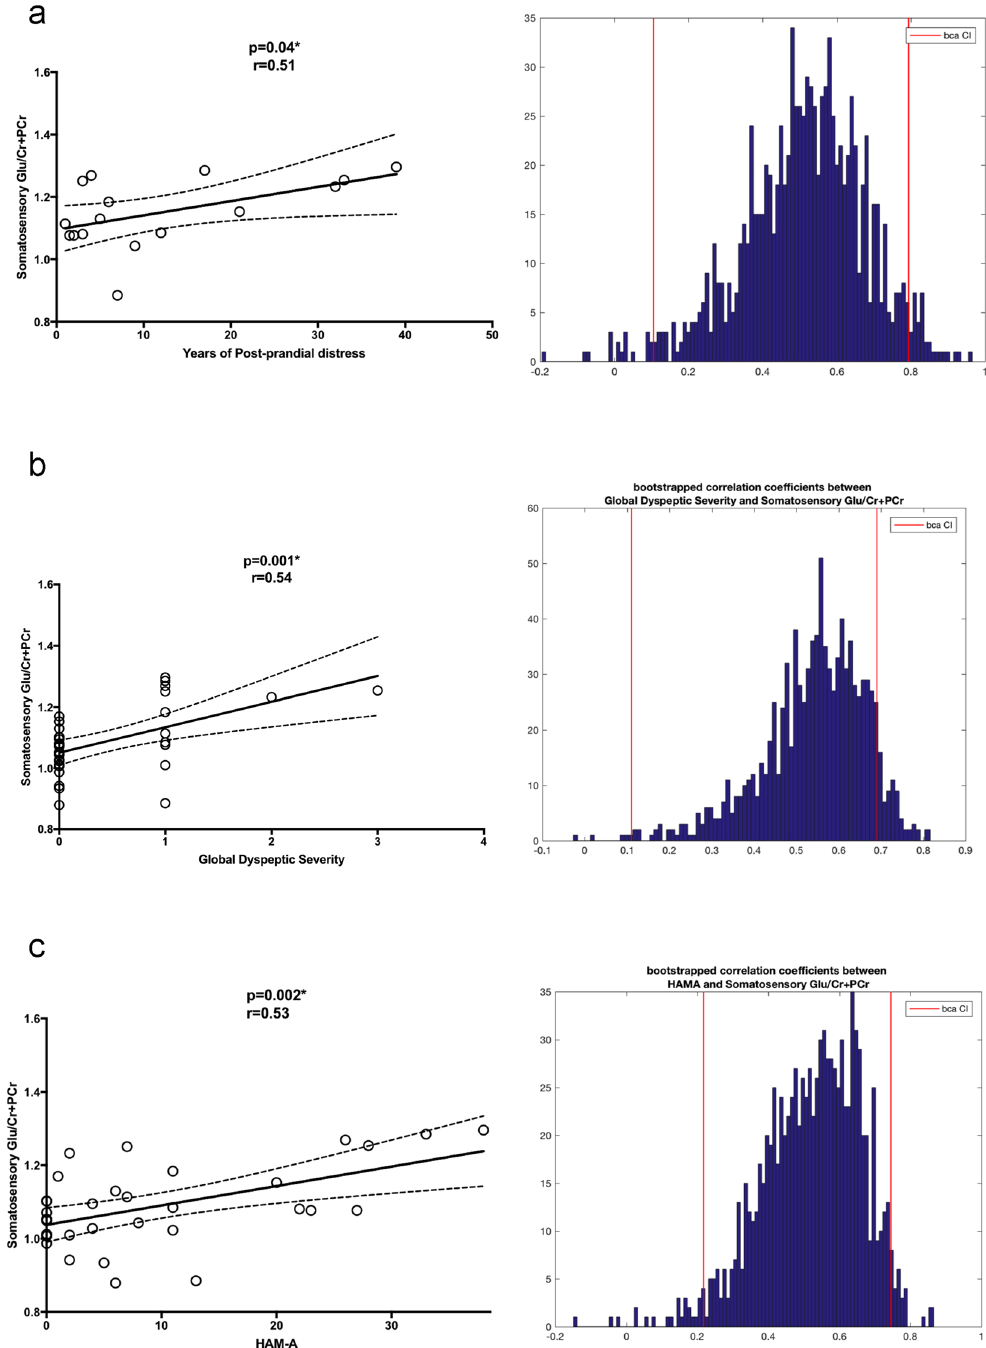
Figure 3. Somatosensory Cortex Glu and Clinical variable Correlations. Diagrams showing significant correlation between ( a ). Post-prandial Distress Chronicity (in years), ( b ). Global Dyspeptic symptom distress, and ( c ). Anxiety severity (HAM-A) with Somatosensory Glu/Cr + PCr ratio, accompanied with histograms of Bootstrapped correlation coefficients. Bias Corrected Accelerated (BCa) 95% CI is indicated by the red vertical lines. Glu/Cr + PCr = relative regional Glutamate concentration with total regional creatine + phosphocreatine as reference